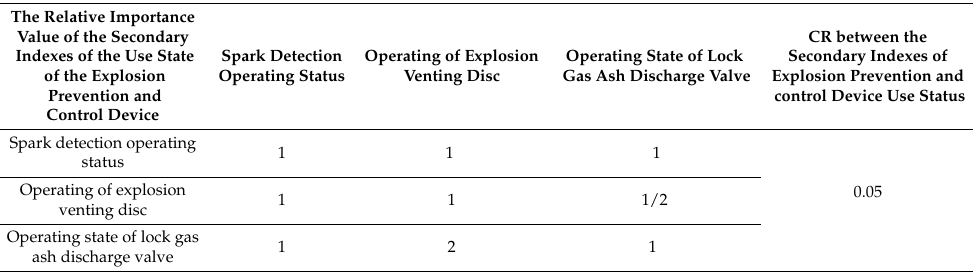
Table 10. Examples of experts’ judgment matrix and consistency test results for the evaluation indicators between the secondary indicators of the use status of explosion-proof